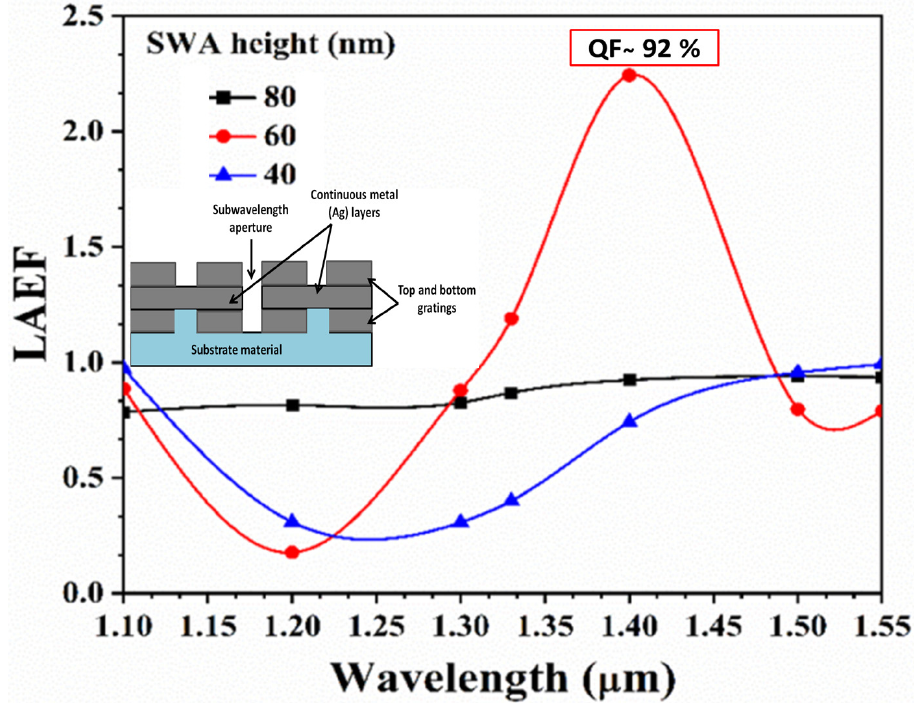
Figure 9. The schematic design and simulated performance characteristics of double silver grating MSM-PD [46].